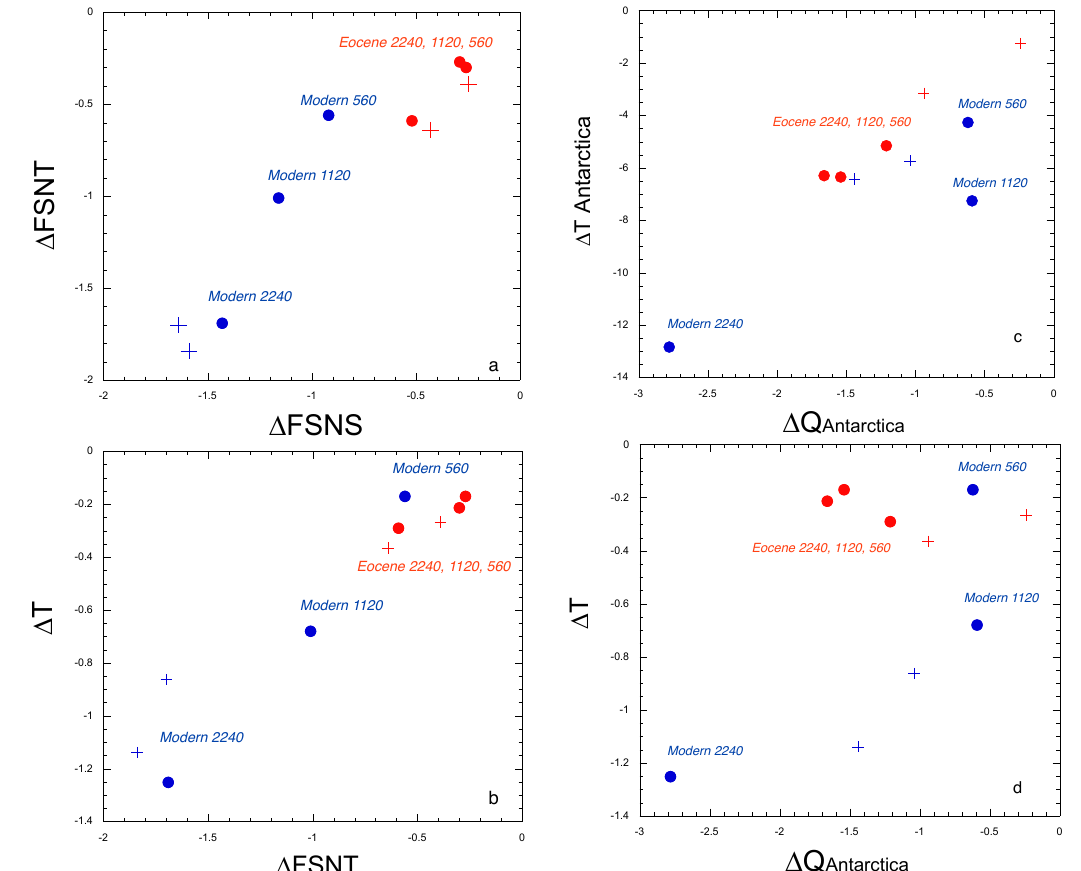
Figure 4. The colored circles are the Eocene (colored red) and Modern (colored blue) slab ocean glaciated versus Fig. 5. The circles represent slab ocean glaciated versus unglaciated comparisons where albedo and topography are changed ( α +oro) and unglaciated comparisons where albedo and topography are changed (Table 1), the cases are labeled on the graph labeled with their corresponding CO 2 level and time period (Eocene: red, modern: blue) (Table 1). The red crosses are the Eocene (red) with their corresponding CO 2 level. The colored red crosses are the Eocene (colored red) and Modern (colored and modern (blue) glaciated versus unglaciated comparisons where only albedo ( α ) was changed (Table 1). (a) 1 FSNS (Wm − 2 ) compared blue) glaciated versus unglaciated comparisons where only albedo was changed (Table 1). a) Δ R LI at the surface ( Wm -2 ) along the x-axis compared against Δ R LI TOA ( Wm -2 ) along the y-axis. b) Δ R LI TOA along the y-axis against 1 FSNT (Wm − 2 ). (b) 1 FSNT compared against 1T . Same conventions as in (a, b) for (c) 1Q Antarctica (Wm − 2 ) vs. 1T compared against Δ T along the y-axis.